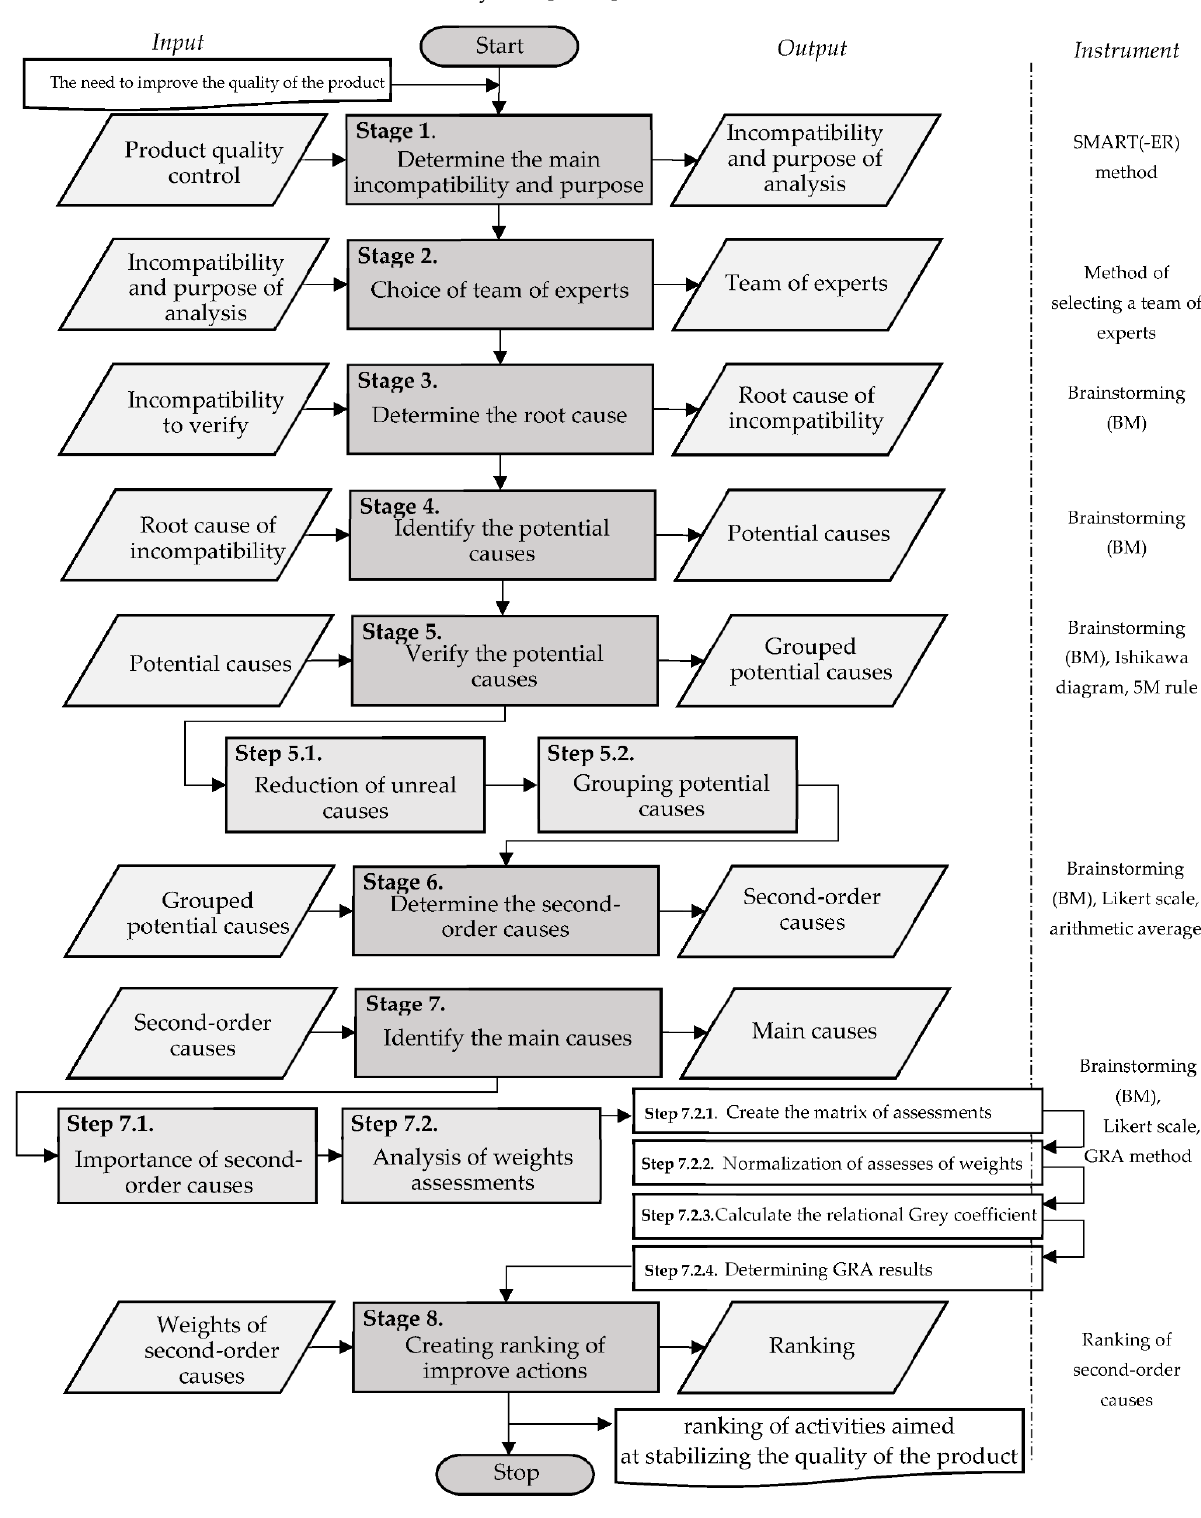
Figure 2. Model supporting stabilization quality of industrial products.